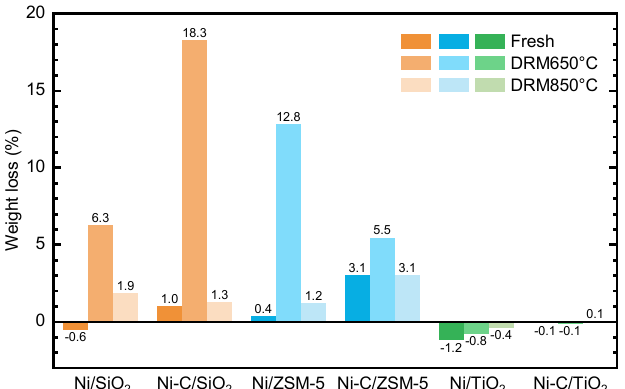
Figure 7. Weight loss calculated from TGA trace.